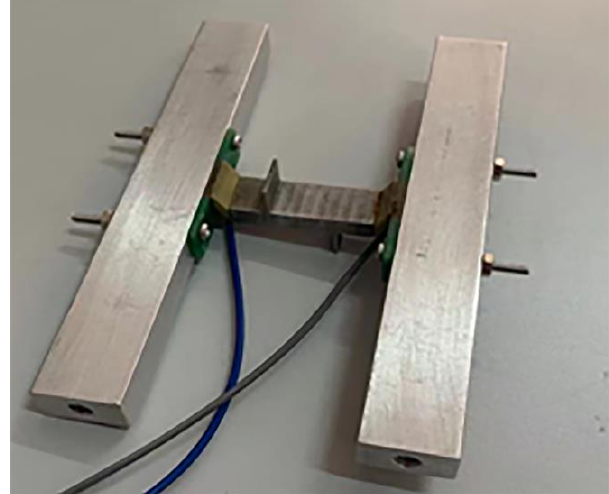
Figure 10. Improved motor